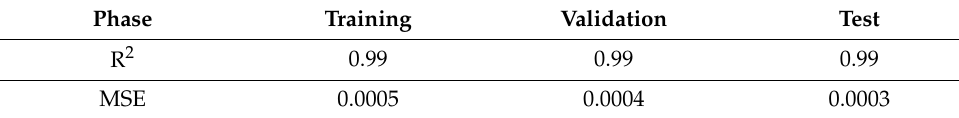
Table 5. Regression analysis of the developed ANN.